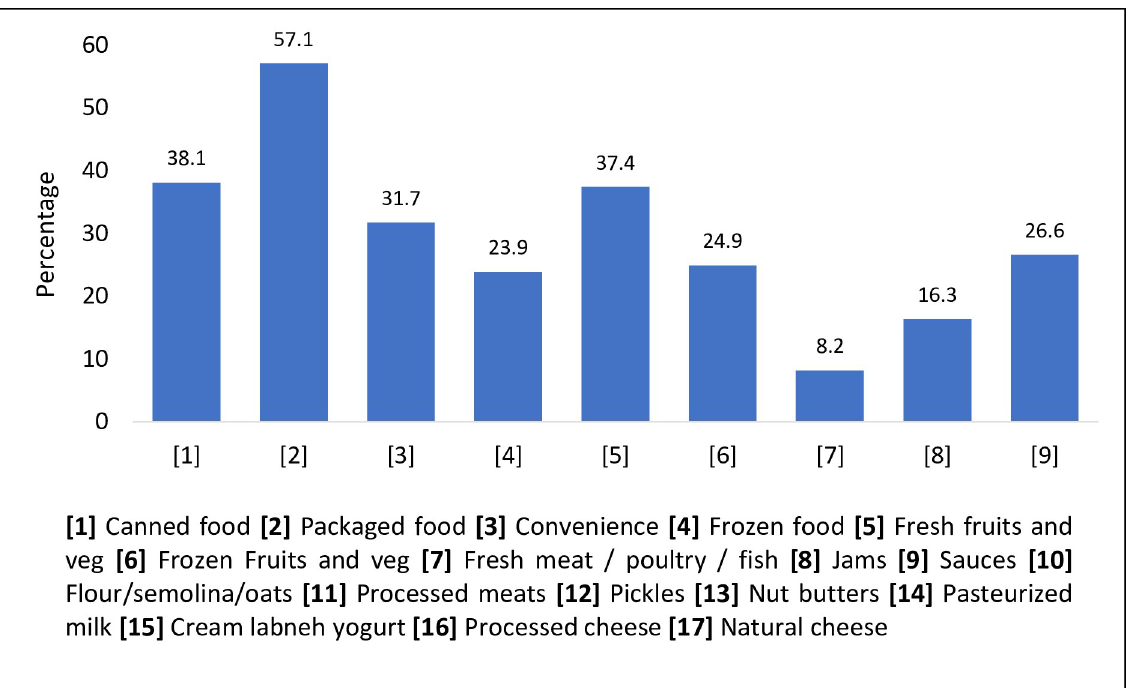
Fig 3. The percentage of respondents who believed about the presence of food addtives in different food items (n =